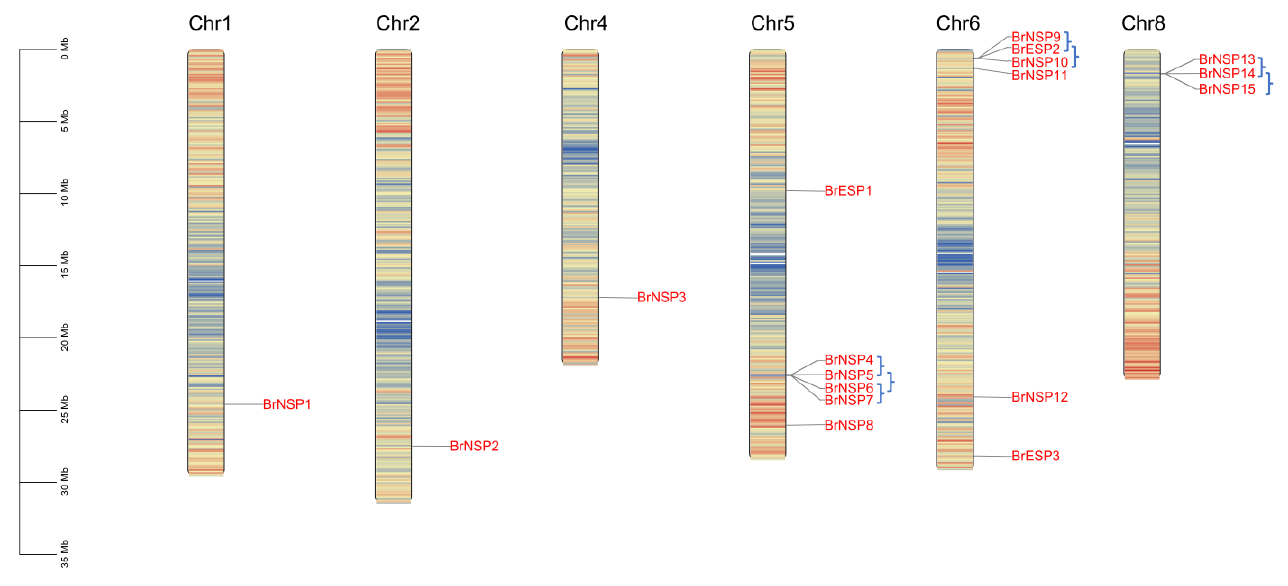
Figure 1. Chromosomal location of ESP and NSP genes in the Chinese cabbage genome. Tandemly duplicated genes are represented by blue brackets.